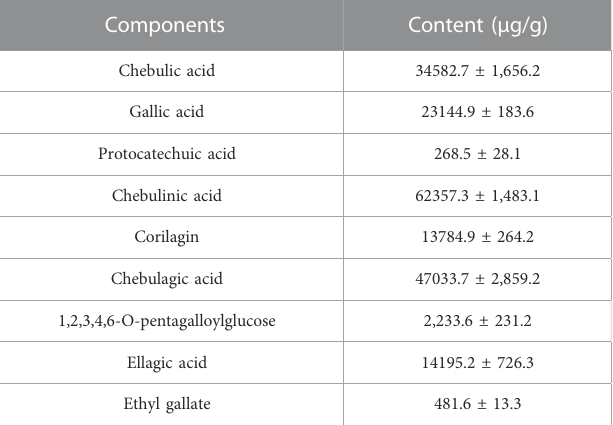
TABLE 2 The content of nine analytes in TC extracts ( n =